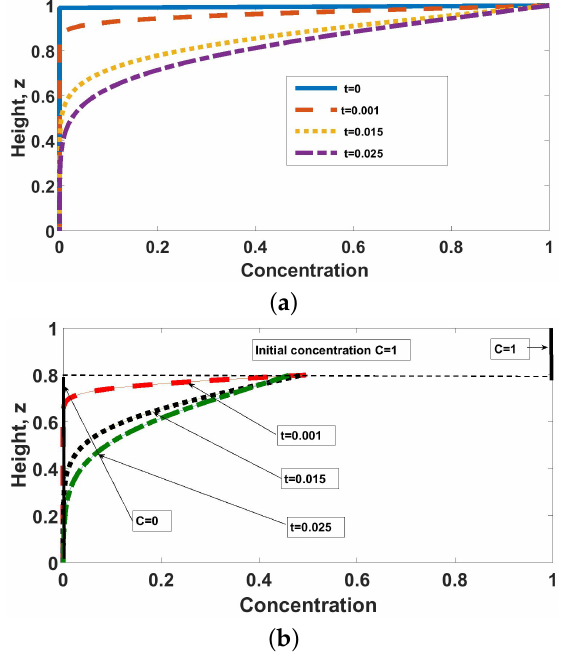
Figure 1. The two plots contrast the time-evolving base state profile, Equation (3) ( a ) and the step-function base profile, Equation (5) ( b ). In the former, a carbon-rich layer forms at the top and grows with time until instability onset, while in the latter it is assumed that after an initial layer of thickness ( 1 − z 0 ) and of average concentration C = 1 has initially formed, its stability to arbitrary infinitesimal time-dependent perturbations is